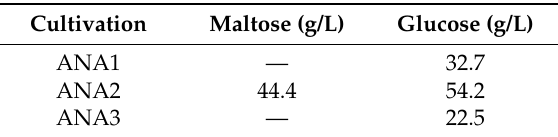
Table 2. Starting sugar concentrations in different anaerobic batch runs (ANA) extracted by high-pressure liquid chromatography (HPLC) measurements.